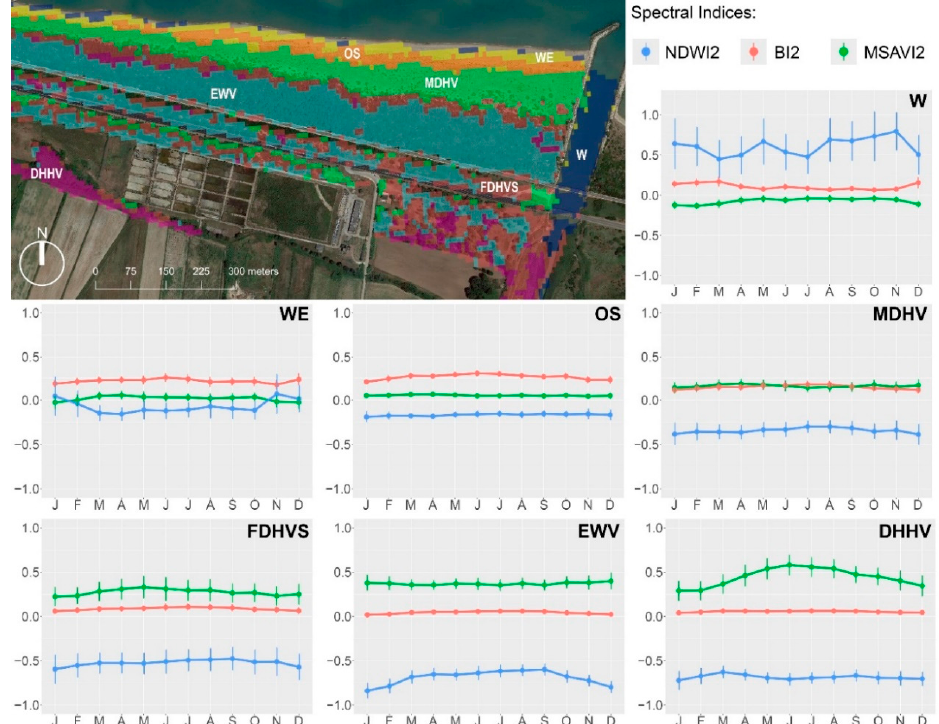
Figure 5. An example of the obtained land cover map reporting classes projected on Google Earth View (on the top) along with monthly average values of NDWI2, BI2, and MSAVI2 ± standard deviation. Water (W), Sand (S), Vegetation (V), Water Edge (WE), Open Sand (OS), Mobile Dune Herbaceous Vegetation (MDHV), Fixed Dune Herbaceous Vegetation with Shrub (FDHVS), Evergreen Woody Vegetation (EWV), Deciduous and Humid Herbaceous Vegetation (DHHV).